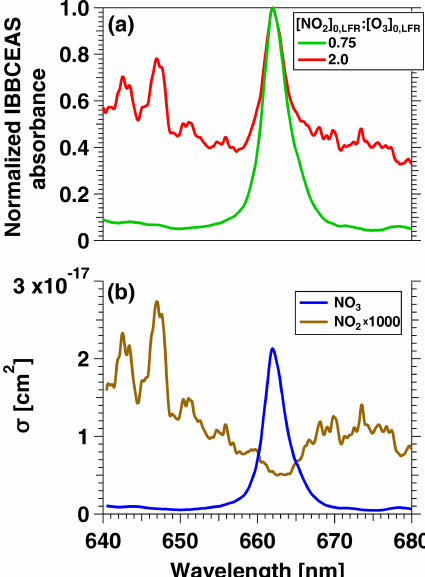
Figure 3. (a) IBBCEAS measurements of NO 2 and NO 3 ab- sorbance obtained from an OFR-iN 2 O 5 characterization experi- ment conducted at [O 3 ] 0 , LFR = 150–160ppm and [NO 2 ] 0 , LFR : [ O ] = 0 . 75 and 2.0. (b) Absorption cross sections of NO 3 0 , LFR and NO 3 (Vandaele et al., 1998; Orphal et al., 2003).